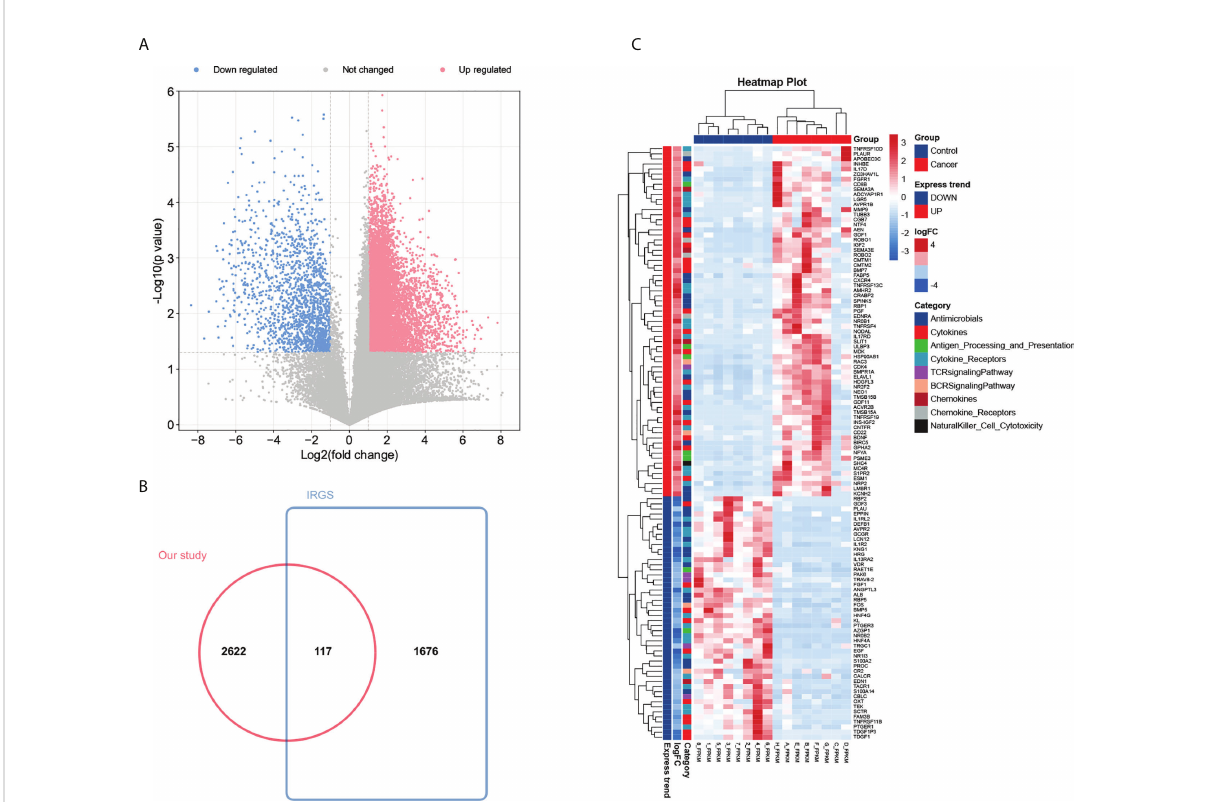
FIGURE 2 Identi fi cation of 117 differentially expressed IRGs in patients with Wilms tumour. (A) Volcano plot of differentially expressed mRNAs by tumour tissue sequencing. (B) Wayne Figure of mRNA sequencing data versus the ImmPort database. (C) Heatmap and clustering analysis of 117 differentially expressed IRGs in patients with Wilms tumour. -4 and 4 represent fold change. High expression is indicated by red, whereas low expression is indicated by green. Different colors represent different immune